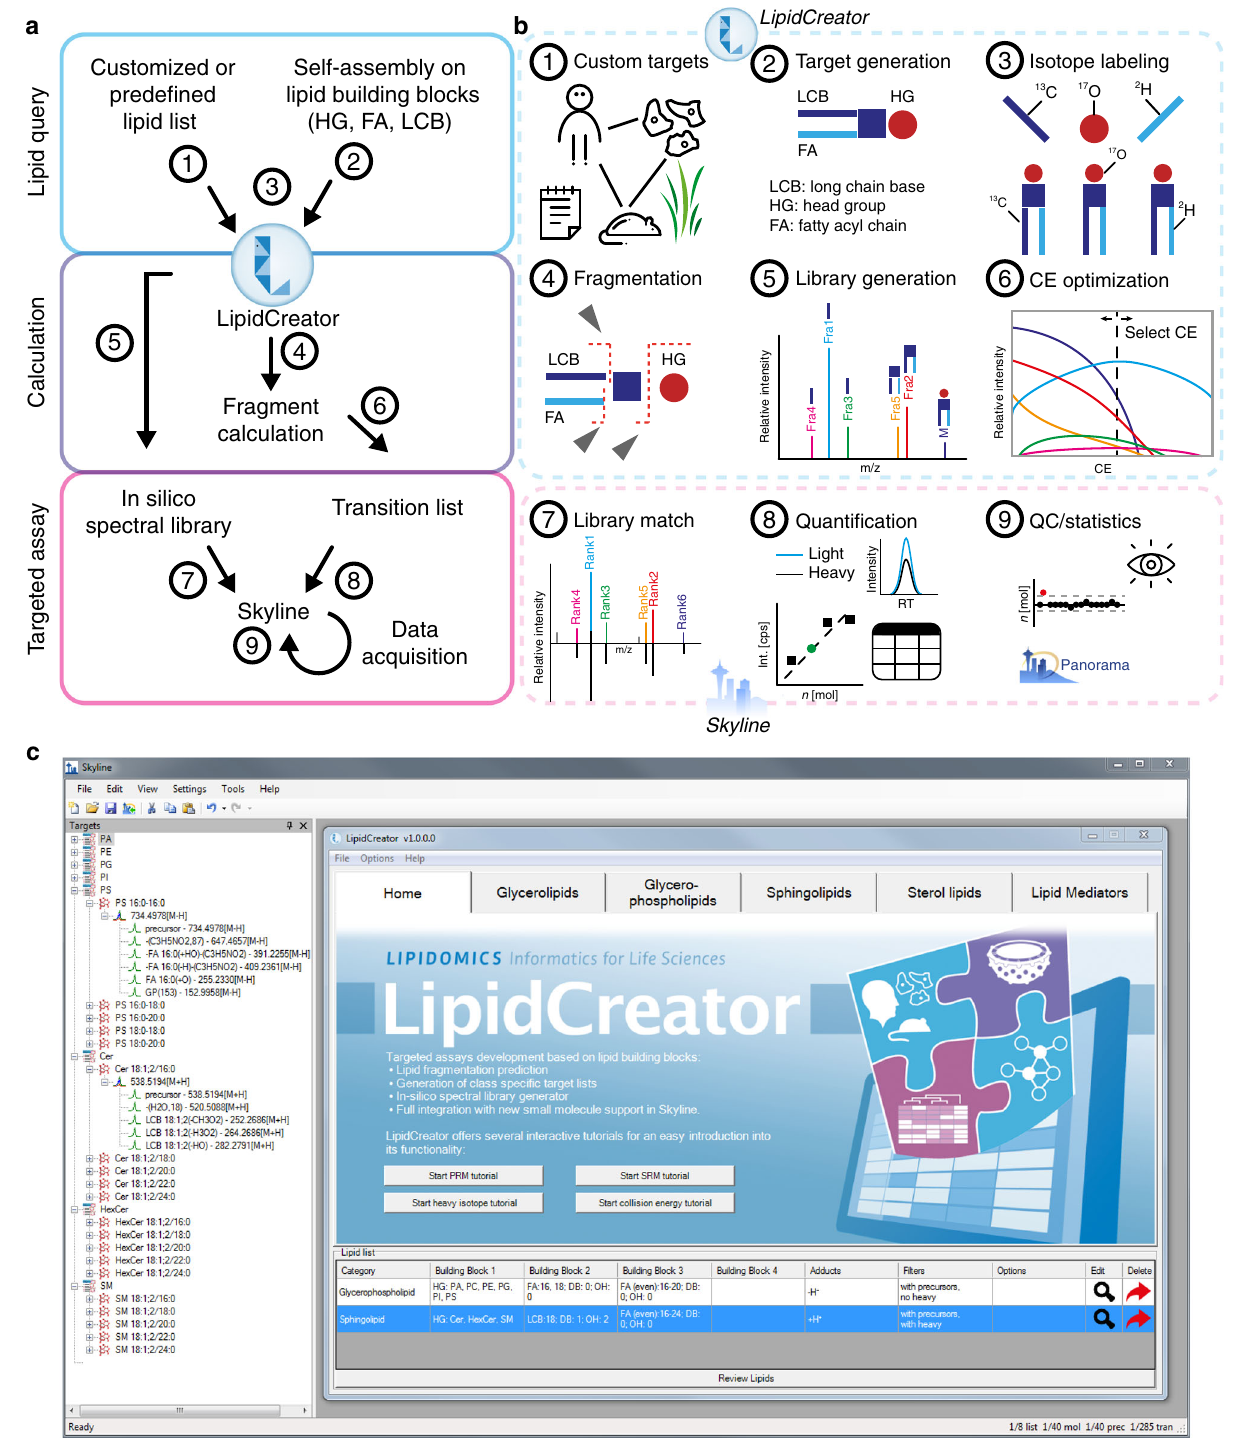
Fig. 1 The LipidCreator workbench and its integration into Skyline. a Main steps include the decision of which lipids to query (Lipid Query), the calculation of the lipid precursor and corresponding fragment masses (Calculation) and the assay design (Targeted Assay). b These main steps consist of the selection of species or lipidomes to target (1 – 2), the inclusion of isotope-coded internal standards for validation (3), the calculation of precursor and fragment masses for the assay (4), library generation (5) and the in silico optimization of CE for individual fragments (6). The steps (1 – 6) are performed in LipidCreator. After the submission of the transition list to Skyline and the execution of the targeted lipidomics experiment, lipids can be validated by spectral library matching (7) and/or their coeluting internal standards, which are further used for quanti fi cation (8). Due to the integration features of Skyline, different downstream quality control systems, such as Panorama, are available (9). c Graphical user interface of LipidCreator integrated into